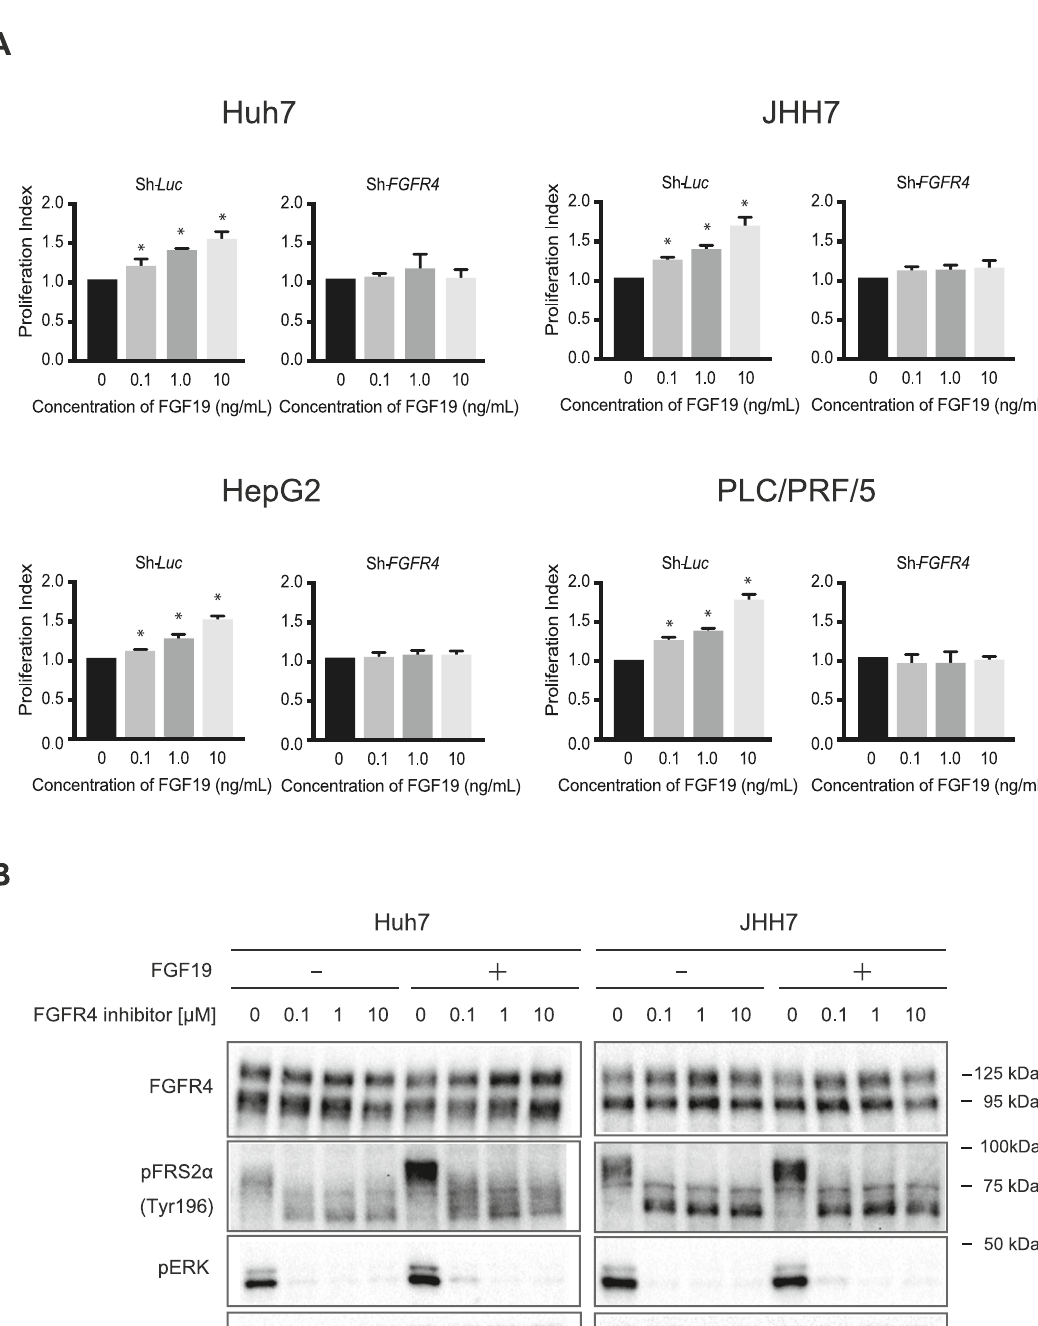
FGF19 + FGFR4 + HCC (n = 33) and FGF19 − FGFR4 − HCC (n = 39) (Fig. 5C). Clinicopathological examination demonstrated that FGF19 + FGFR4 + HCC was significantly associated with a high serum level of AFP ( p = 0.001) and low differentiation pathology ( p = 0.003). In addition, they were subjected to the prognostic analyses by the Kaplan ‐ Meier method. The presence of vascular invasion or tumor satellite nodules are well known factors implicated in recurrence 22 . In fact, the recurrence-free survival (RFS) in patients with vascular invasion or tumor